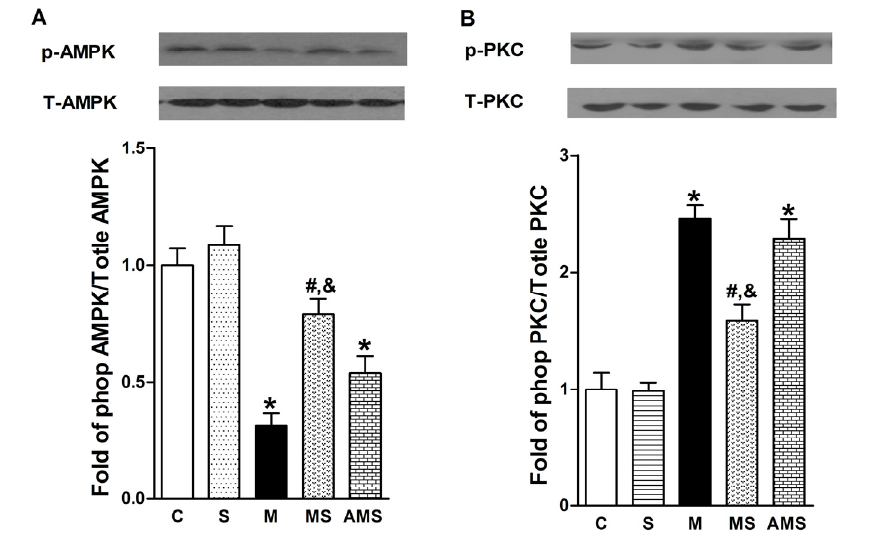
Figure 6. Vagal nerve stimulation modulated ROS generation via AMPK-PKC expression. ( A ) Representative of Western blots for phosphorylated and total AMPK expression from each group; ( B ) Representative of Western blots for phosphorylated and total PKC expression from each group. Data shown are mean ± SEM ( n = 5). * p < 0.05 compared with control (C); # ,& p < 0.05 compared with M and AMS,